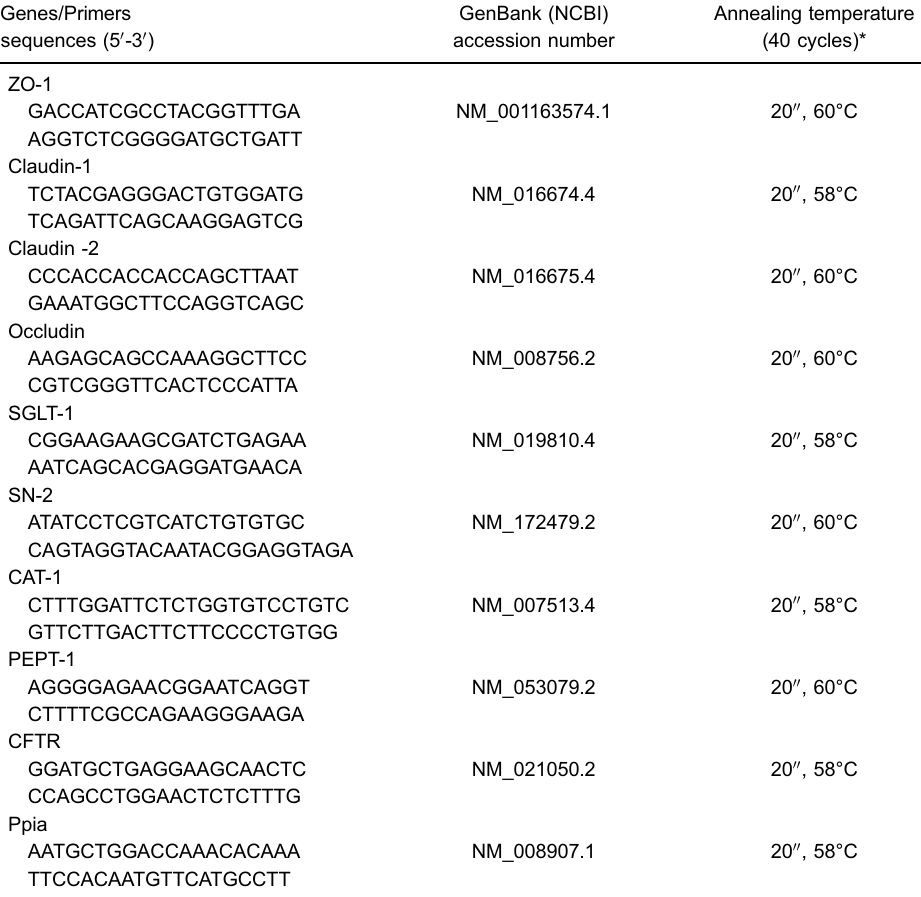
Table 1. Description of genes, primers sequences, accession numbers (NCBI) and qRT-PCR conditions.